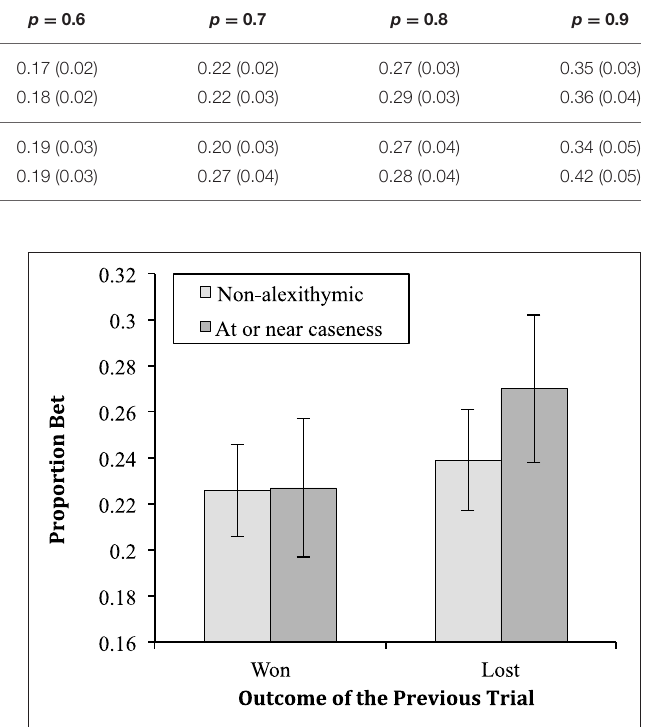
FIGURE 2 | The proportion bet (means and standard errors) for the alexithymia groups having won or lost on the previous